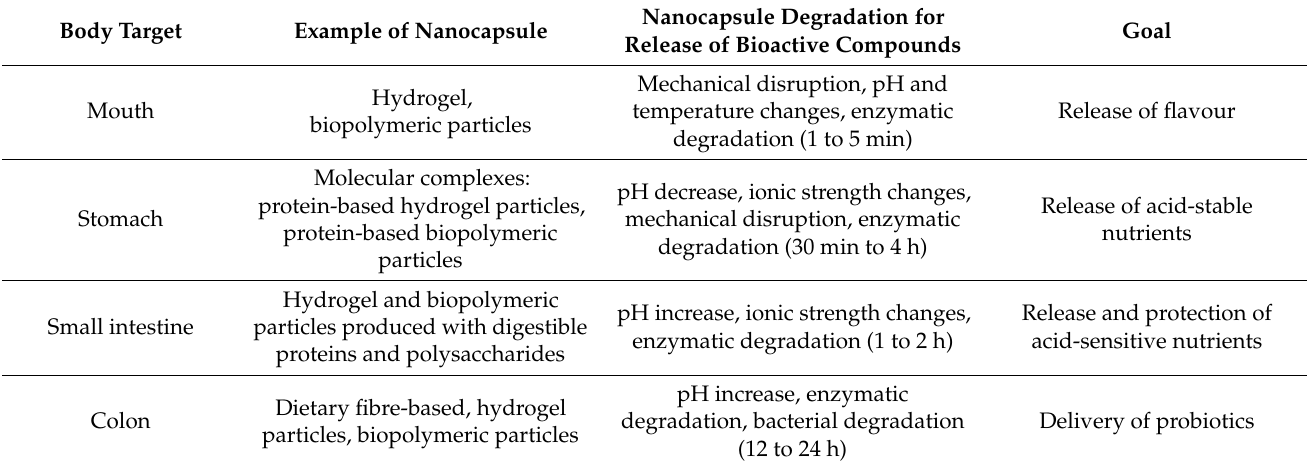
Table 4. Nanocapsule absorption in the human body